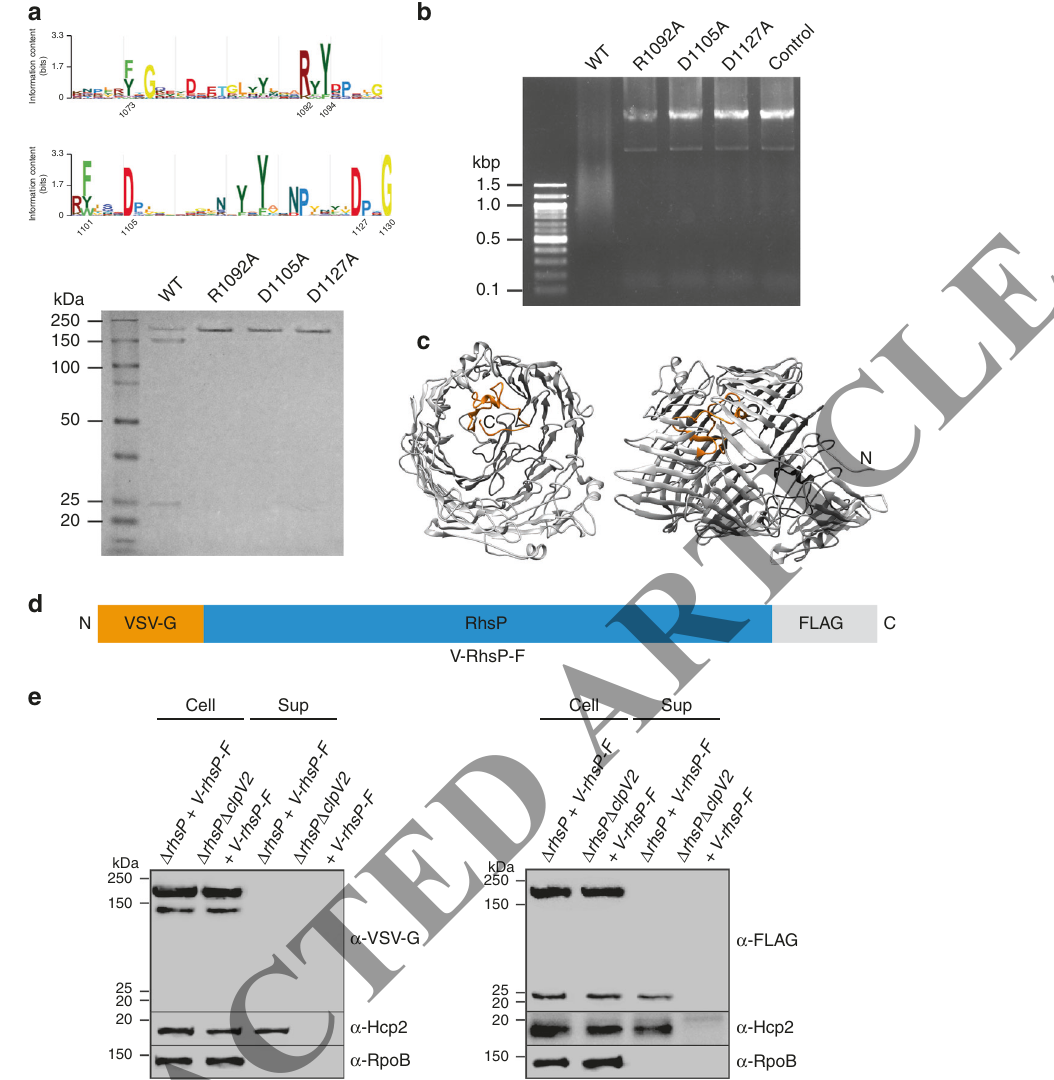
Fig. 2 RhsP is a pro-effector of T6SS2. a A conservation pattern of RHS-terminal aspartic protease containing active site residues of R1092, D1105, and D1127. The fi gure was created with WebLogo Software Copyright (c) 2002 Regents of the University of California. Lower panel: RhsP was self-cleaved under low pH (pH = 4), and site-directed mutagenesis in any of the three conserved residues abolished the auto-proteolysis of RhsP. b Self-cleaved RhsP digests E. coli genomic and plasmid DNA, while the RhsP derivatives that lost proteolytic activity failed to do so. Extracted bacterial DNA was incubated with RhsP or its derivatives at acidic condition for 4 h. The reaction mixtures were then run on 1% agarose gel. A control shows that DNA was not affected by the incubation condition. c Homology model of RhsP. Phyre2 server was used to construct a homology model of RhsP by alignment of RhsP residues 317 – 1131 with the template structure of the TcB – TcC toxin. Left: Top view of the RhsP model. The Rhs repeat region was modeled in grey and the aspartic protease was modeled in orange. Right: Side view of the RhsP homology model, rotated 90° around the vertical axis. d Schematic illustration of RhsP construct with double epitope tags for subsequent RhsP expression and secretion analysis. For ( c ) and ( d ), amino and carboxyl termini are denoted as N and C, respectively. e Western blot analysis of RhsP expression and secretion. RhsP construct with double tags was expressed in Δ rhsP and Δ rhsP Δ clpV2 of V. parahaemolyticus RIMD2210633. α -VSV-G was used to recognize the VSV-G epitope at the N-terminal of V-RhsP-F and α -FLAG was used to recognize the FLAG epitope at the C-terminal of